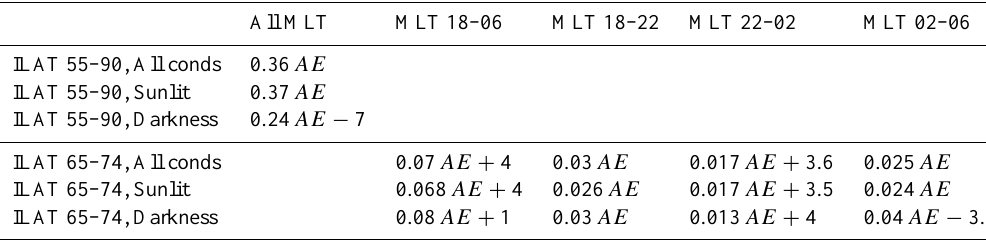
Table 2. Joule heating (GW) as a function of AE index (nT) in different hemispheric regions. All MLT